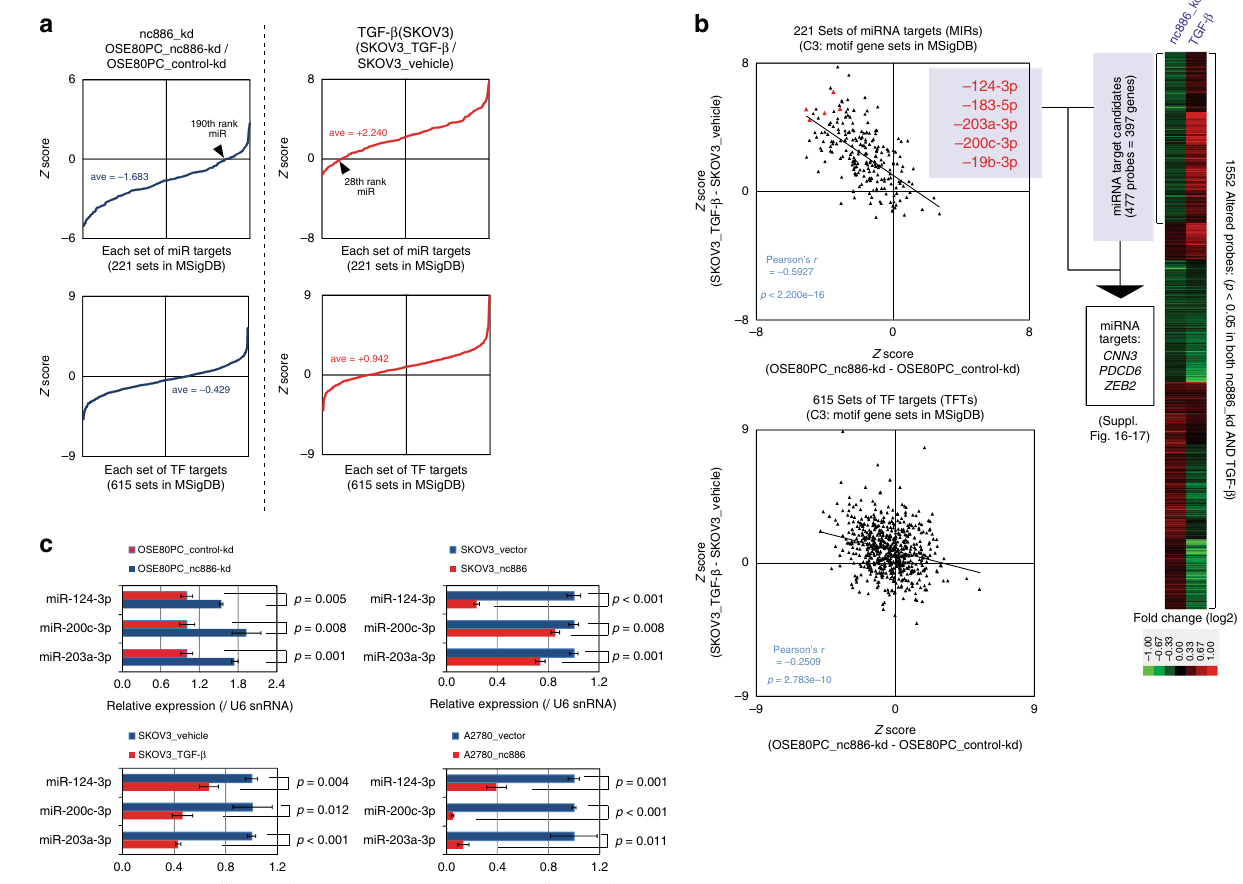
Fig. 4 nc886 suppresses the miRNA pathway. a Rank distribution plots of MIRs (top) and TFTs (bottom) upon nc886 kd (left panel) and TGF- β treatment (right panel). Z -scores were sorted from the smallest to the largest values and plotted against an anonymous x -axis. See text for details. b Scatter plots of MIR or TFT Z -scores between nc886 kd and TGF- β treatment are shown on the left side. Top fi ve candidate nc886-associated miRNAs were selected through our work fl ow (see Supplementary Fig. 16a and the text) and their data points are red highlighted. On the right, a heat map shows clustering of genes that were signi fi cantly altered in nc886 kd and TGF- β treatment. One cluster contains 397 candidate miRNA target genes (see Supplementary Data File 6 for a complete list), which were cross-compared to the 5 miRNAs (see Supplementary Table 5 and Supplementary Fig. 16b for details) to yield CNN3 , PDCD6 , and ZEB2 as direct targets. c Taqman miRNA qRT-PCR assays, with small nuclear RNA U6 (U6 snRNA) for normalization